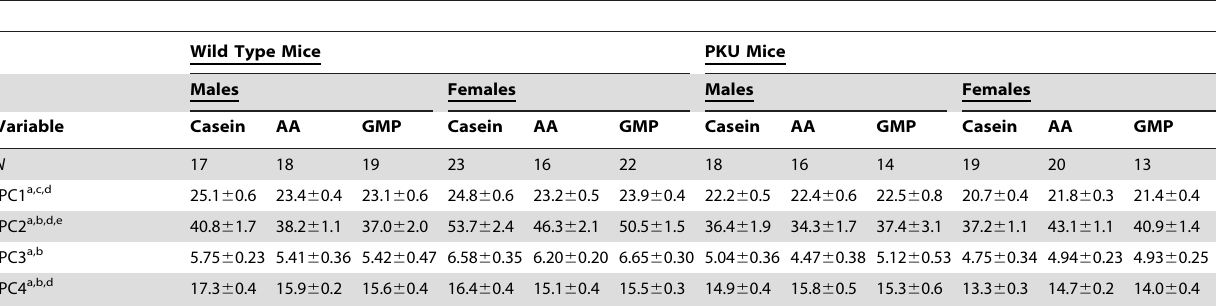
Table 8. Principal component phenotypes of WT and PKU mice fed casein, AA, and GMP diets.